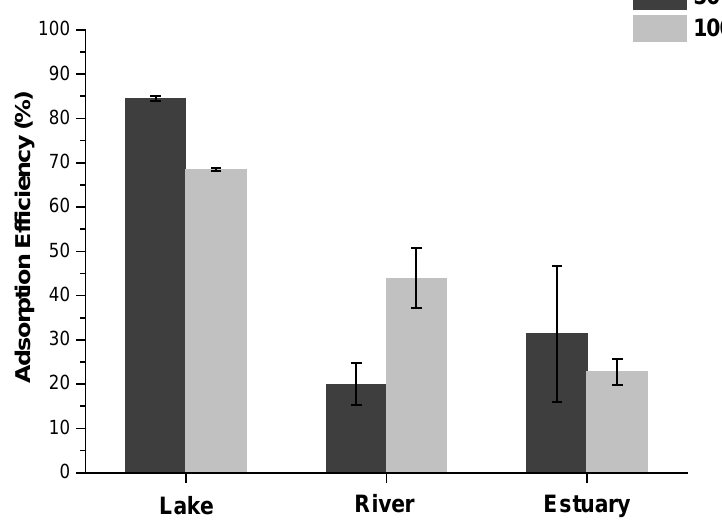
Figure 2. Adsorption efficiency (%) of ibuprofen at concentrations of 50 µM and 100 µM by TpBD-(CF 3 ) 2 ( C 0 = 330 mg L − 1 ) in natural water samples collected from a lake, river, and estuary.